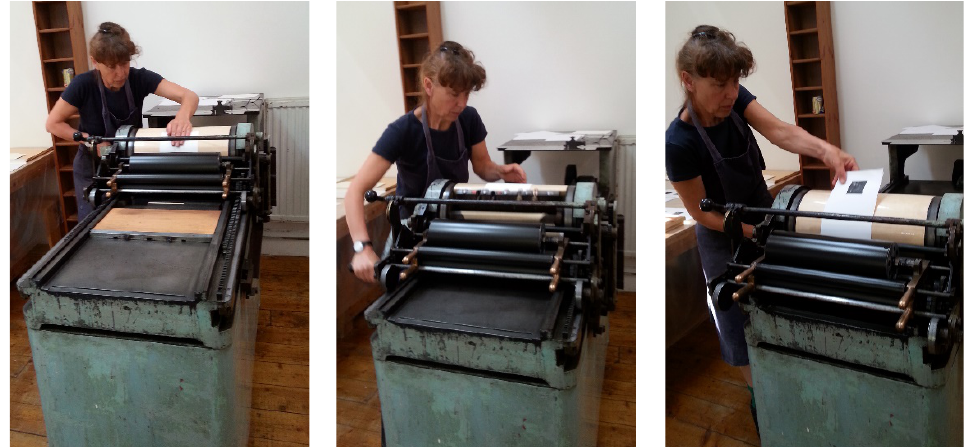
Figure 1. Helen Douglas (Weproductions) (2014) printing on her Vanderook no.4 at Deuchar Mill, Yarrow, Scotland. Photos courtesy of Helen